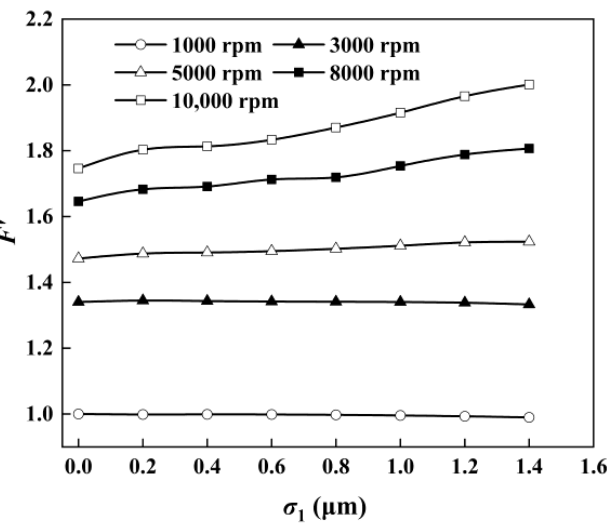
Figure 10. Effect of roughness of the grooved zone of the rotating ring on the opening force of the lubrication film.